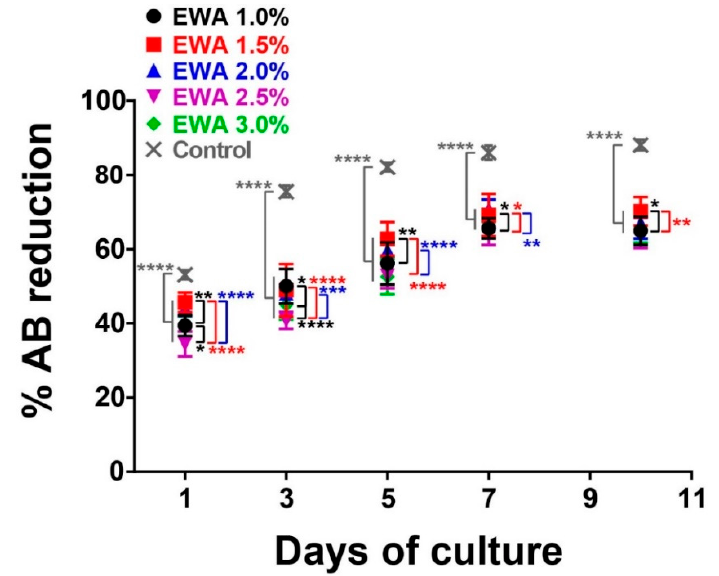
Figure 6. The growth rates of NS-SV-AC seeded on EWA at 1, 1.5, 2, 2.5, or 3% alginate. Cells cultured on standard culture plates were used as control. AB stands for AlamarBlue. Data are presented as mean ± SD, n ≥ 3, * p < 0.05, ** p < 0.01, *** p < 0.001, **** p < 0.0001.